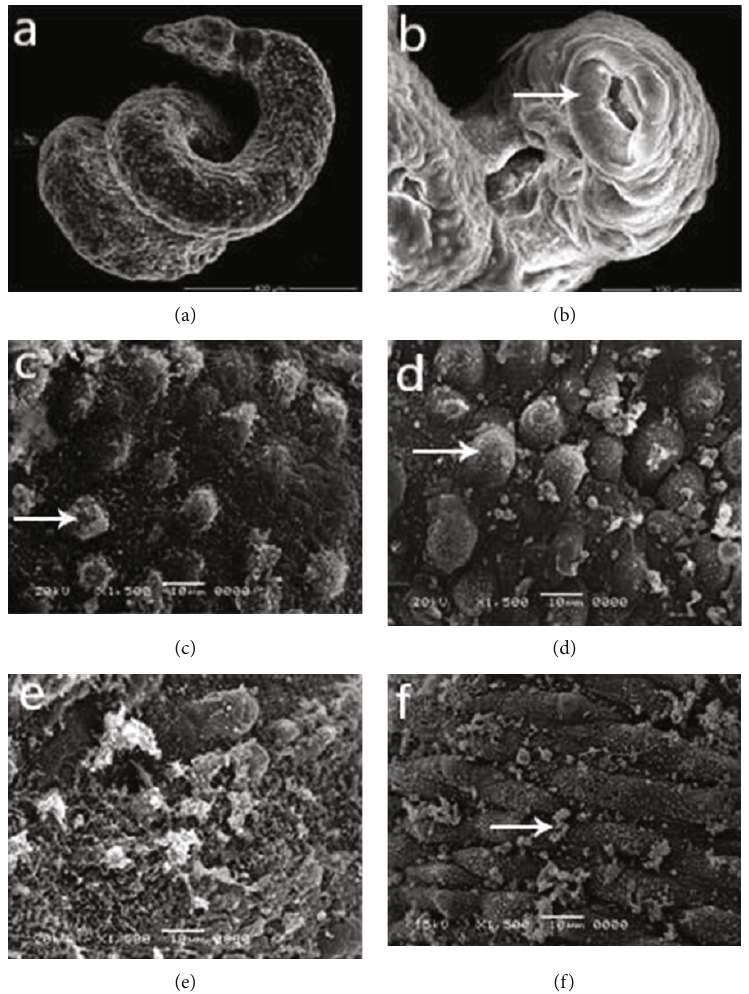
Figure 9: Scanning electron microscopy of S. mansoni (adult worms) after exposure to di ff erent concentration of Zingiber o ffi cinale : (a) destroyed sucker; (b – d) male dorsal surface showing tegumental peeling with damage and peeling of tubercles and